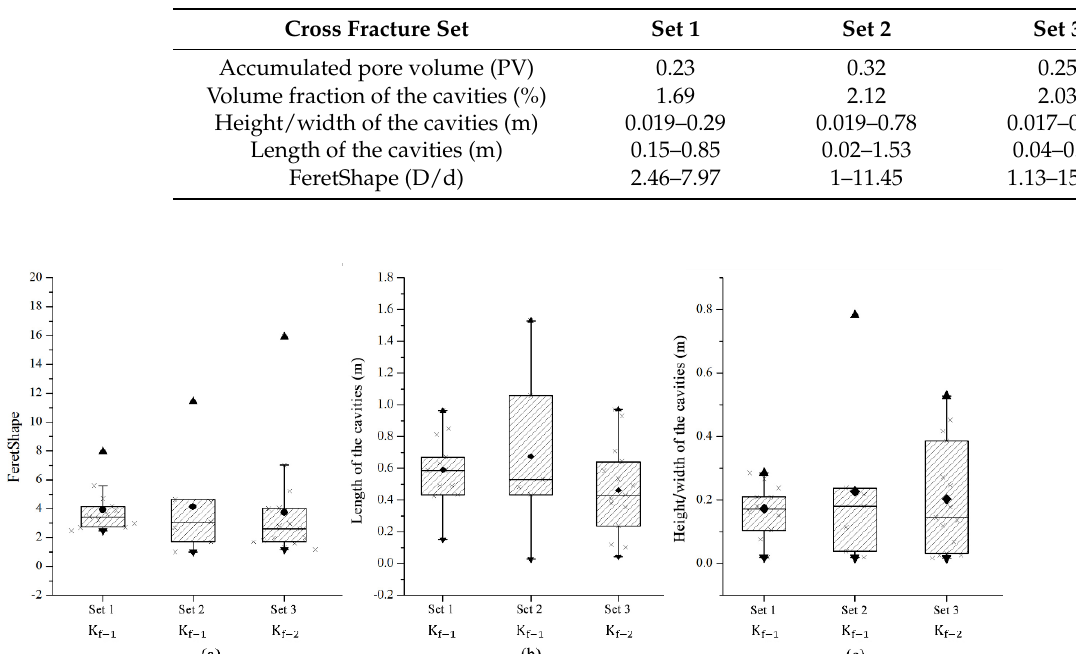
Figure 12. Comparison of the shape parameters for different characteristic lengths. Parameter K f − 1 represents the condition under which the permeability of the cross fractures is 1 × 10 − 13 m 2 and the aperture is 1.1 × 10 − 6 m; K f − 2 represents the condition under which the permeability of the cross fractures is 5 × 10 − 13 m 2 and the aperture is 2.45 × 10 − 6 m. ( a ), ( b ), and ( c ) represent the statistical results of FeretShape, length of cavities, height/width of cavities with different cross fracture sets, respectively.